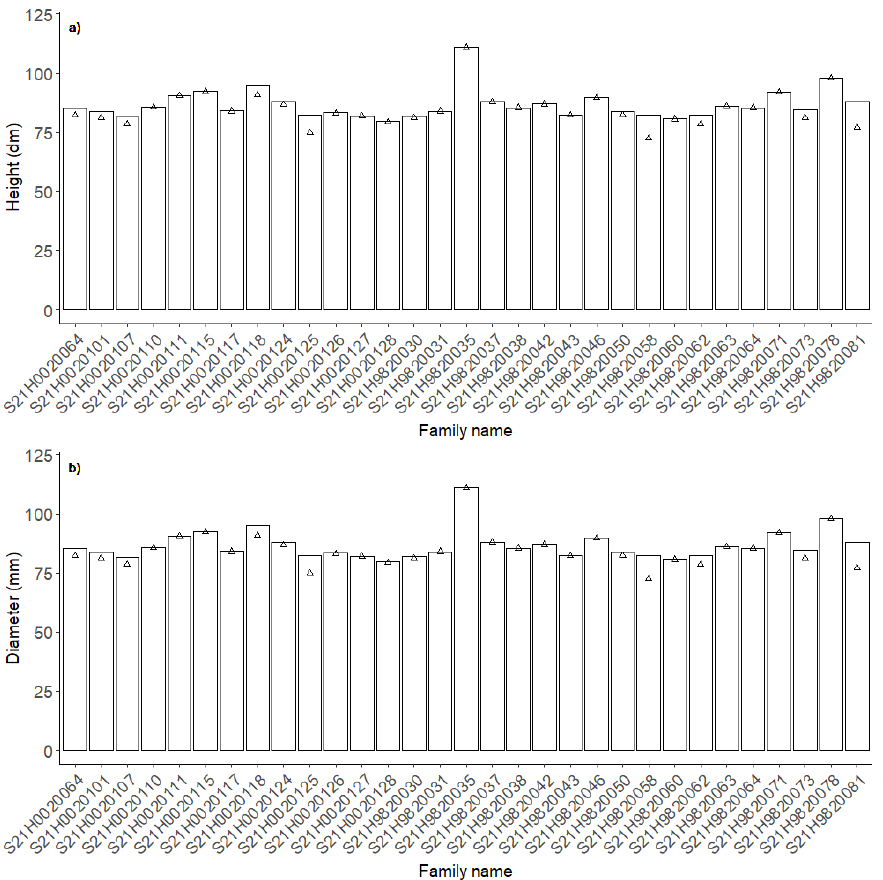
Table 6. Mean heights (m) and diameters (mm) at 12 years of genotypes selected using indicated models when just the best genotype per family was selected. H and D are reference values for selection after manual measurement.